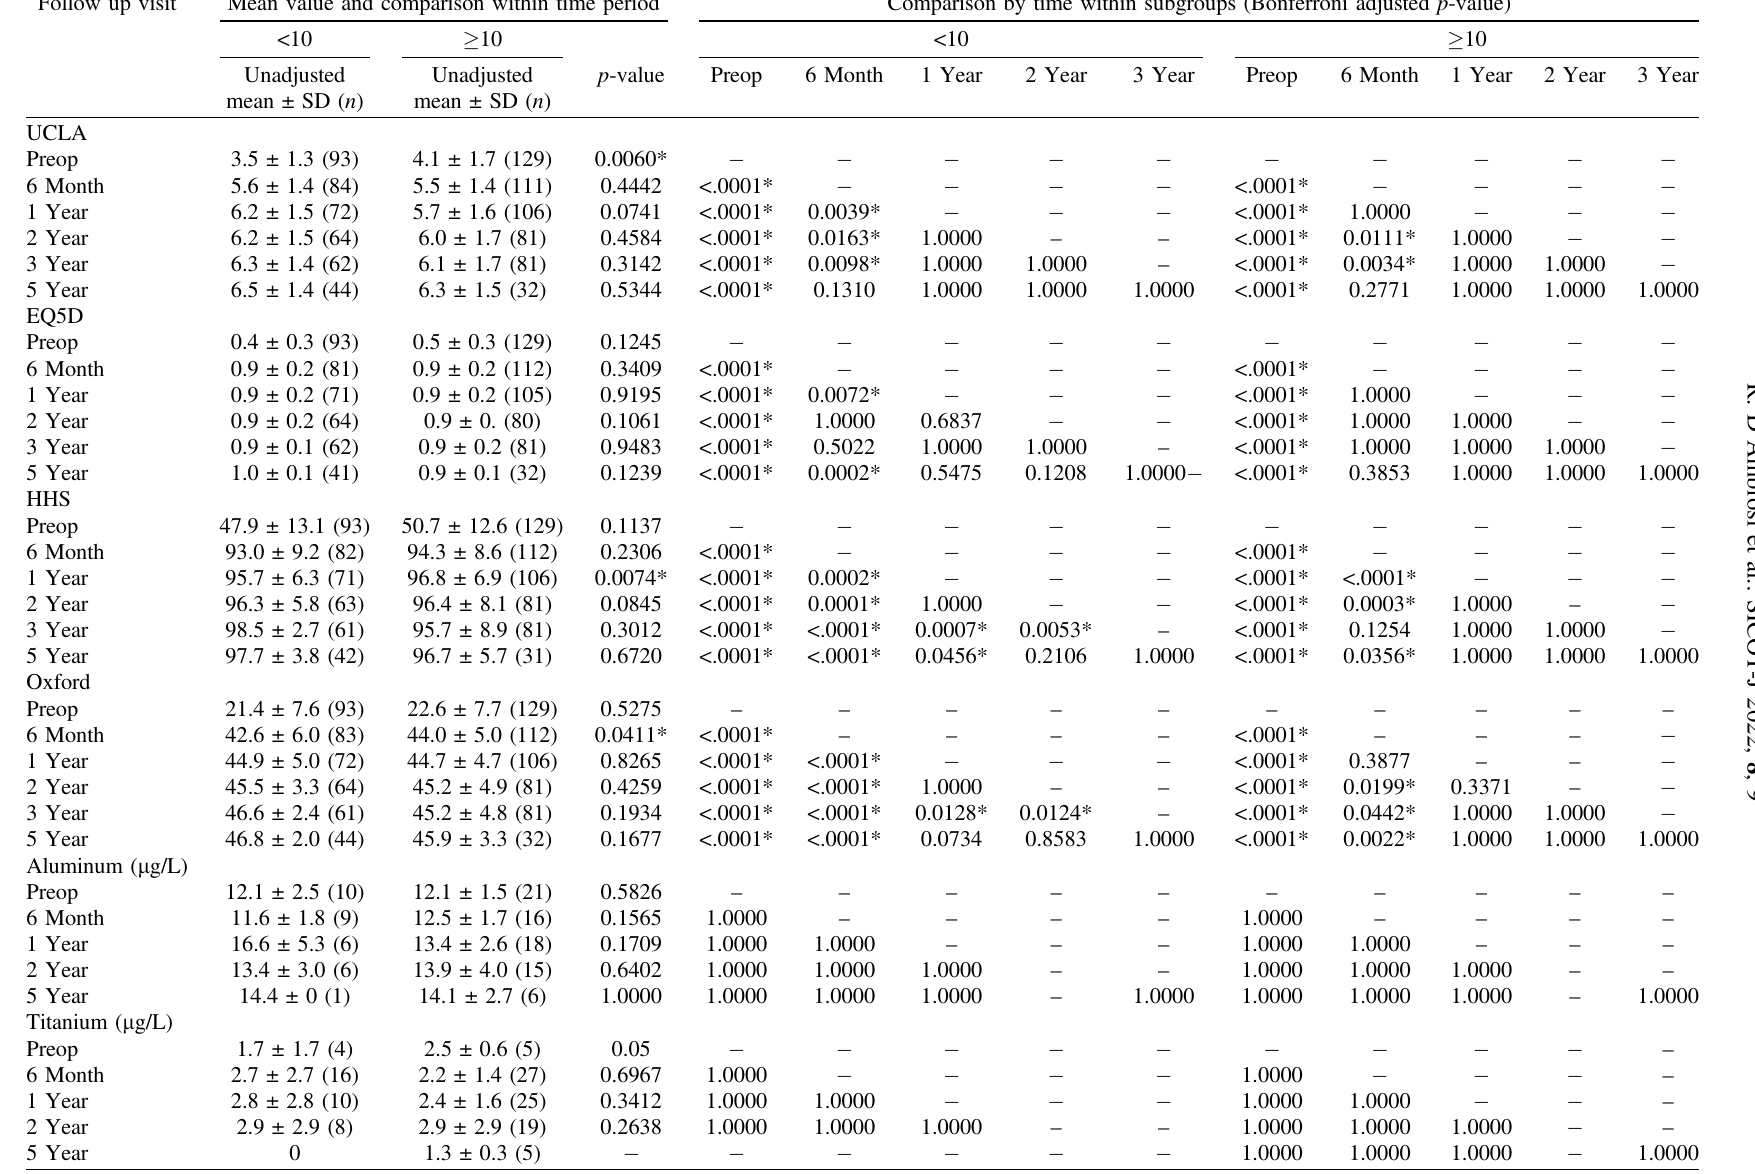
Table A.10. Subgroup analysis by femoral size. Follow up